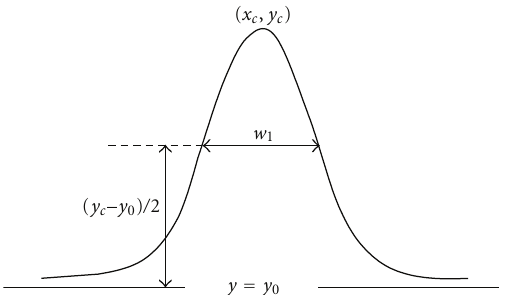
Figure 3: Schematic representation of the parameters used to calculate the full width at a half maximum (FWHM) for a normal distribution. Adapted from Origin User Guide [28].